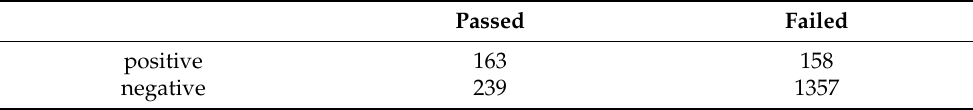
Table 2. Confusion matrix based on RO4 with one